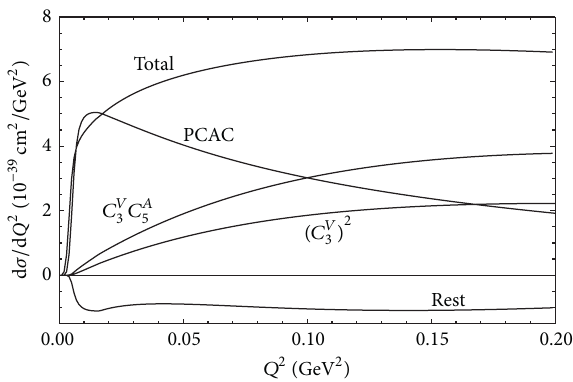
Figure 1: Anatomy of the various contributions to the cross-section at 𝐸 ] = 1